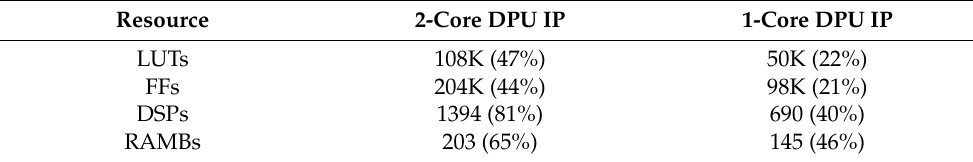
Table 5. FPGA resource utilization for the implemented design on the ZCU104